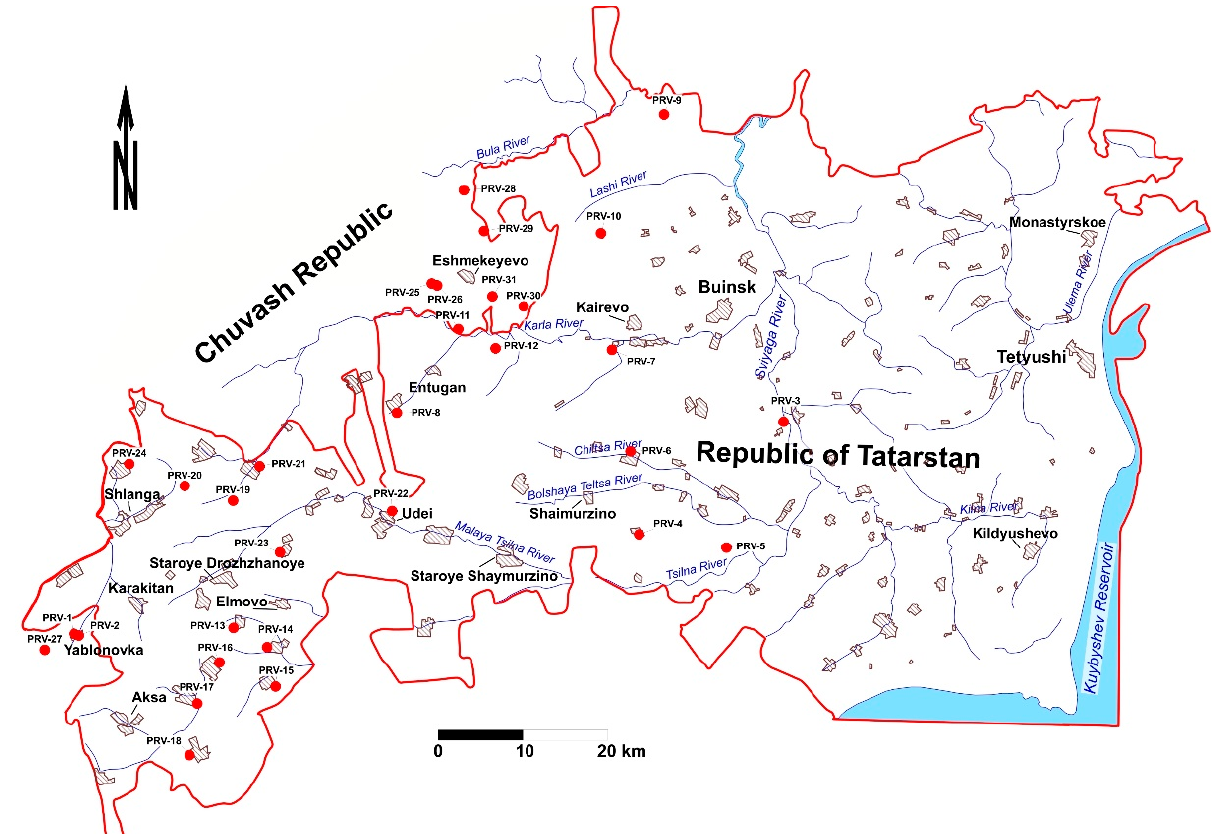
Figure 3. Location of the studied area and sampling points (red solid circles).